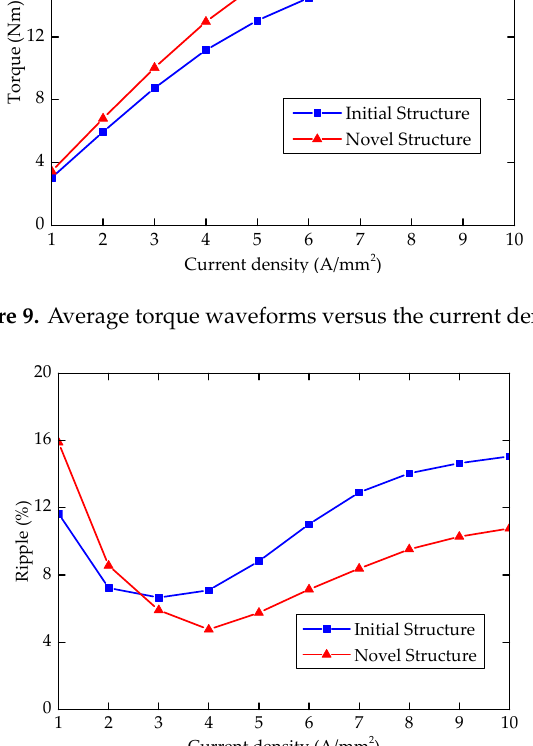
Figure 10. Torque ripple waveforms versus the current density.